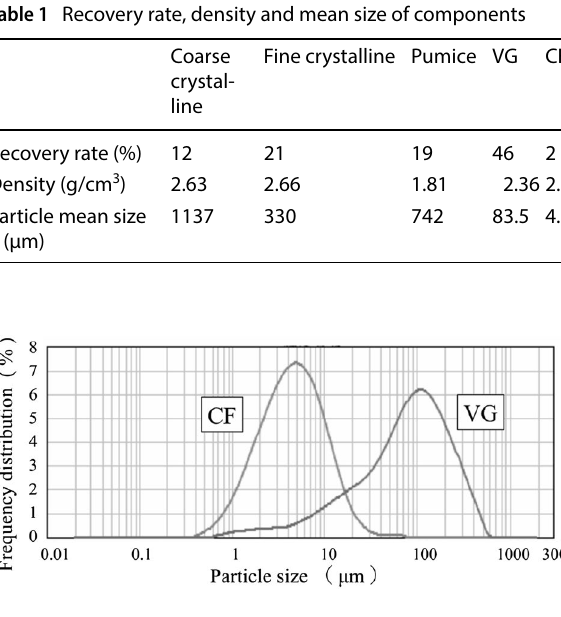
Fig. 6 Particle size distribution of VG and